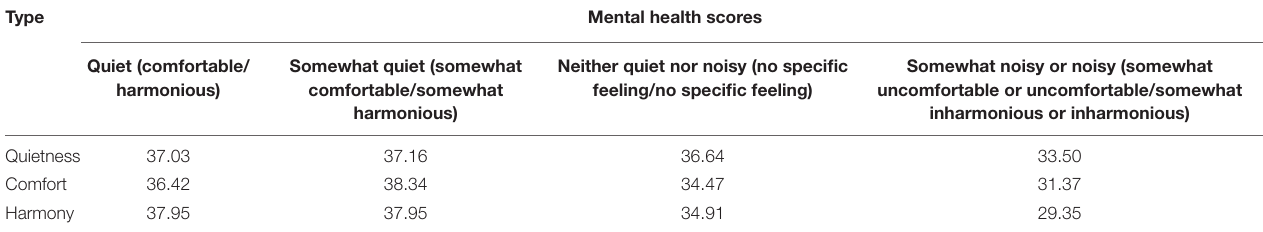
TABLE 3 | The mental health scores based on their evaluations of the acoustic